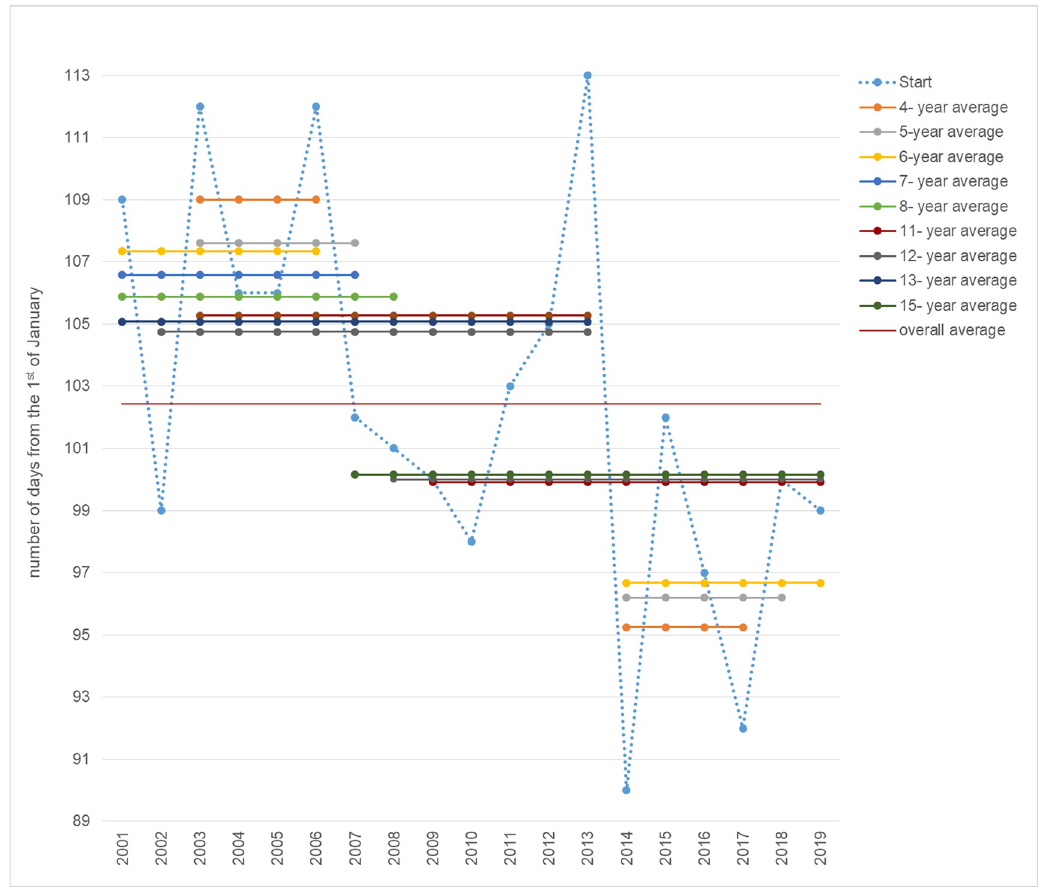
Fig 4. Onset means for sub-periods significantly different from the overall average at a 0.05 significance